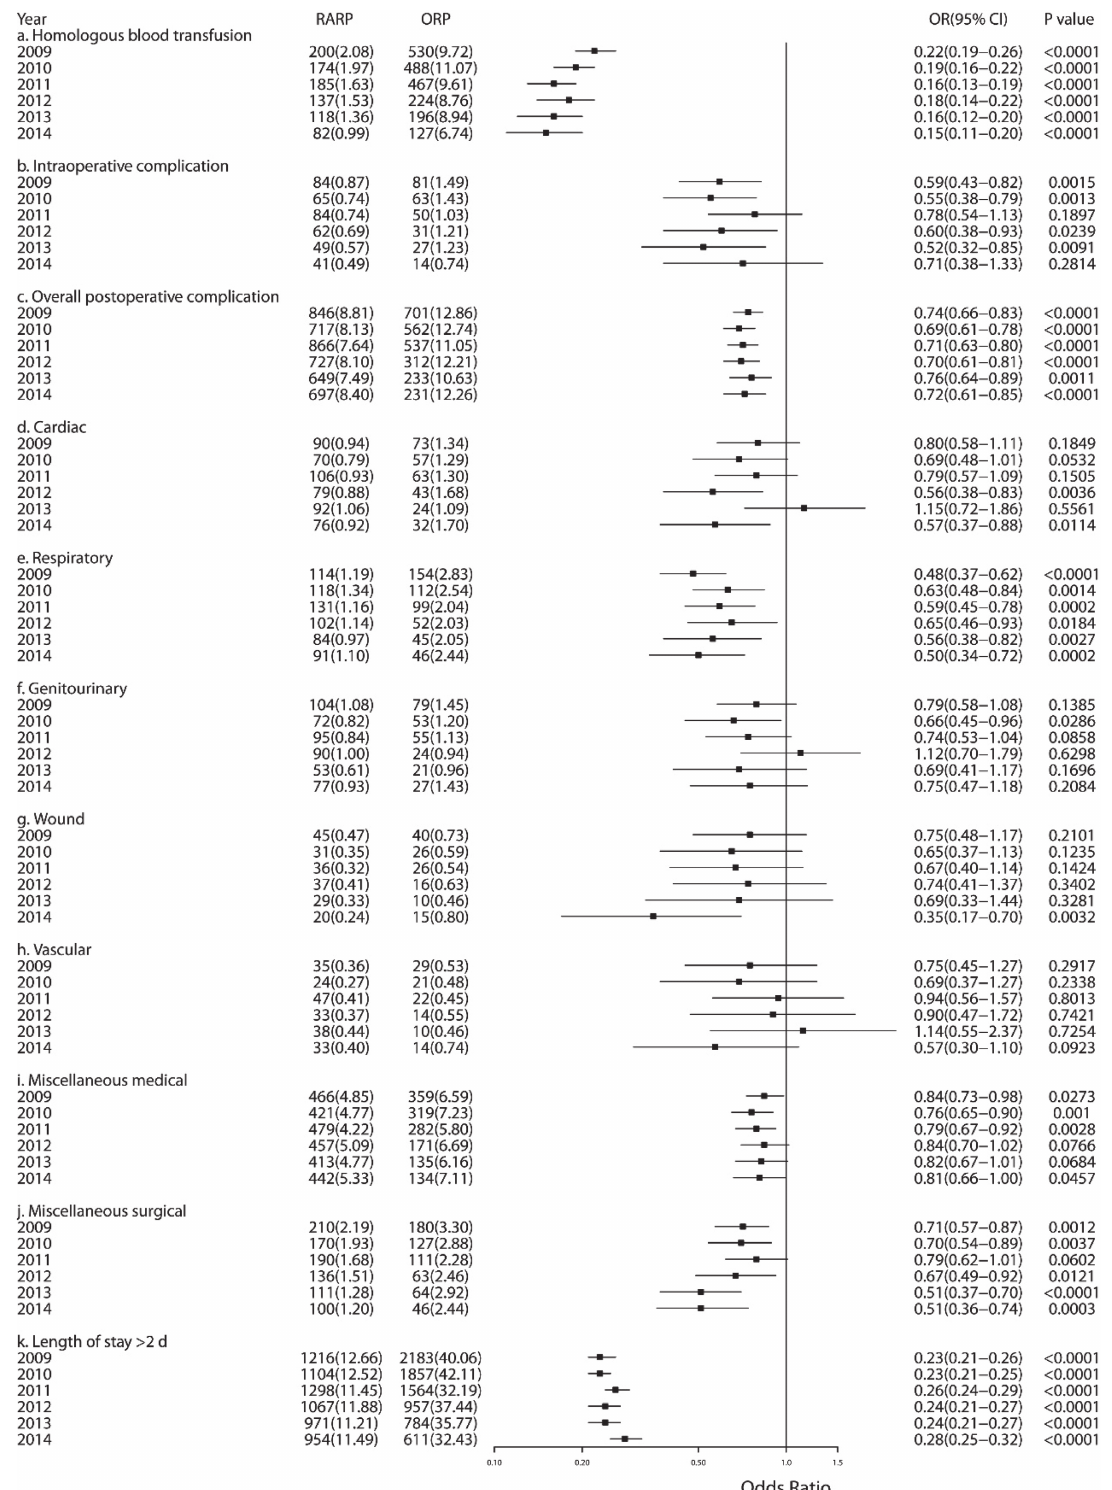
Supplementary Figure 2 - The forest plot of odds ratios for the comparison between Robot-assisted Radical Prostatectomy group with the Open Radical Prostatectomy group from 2009 to 2014 (pre-propensity score-matched